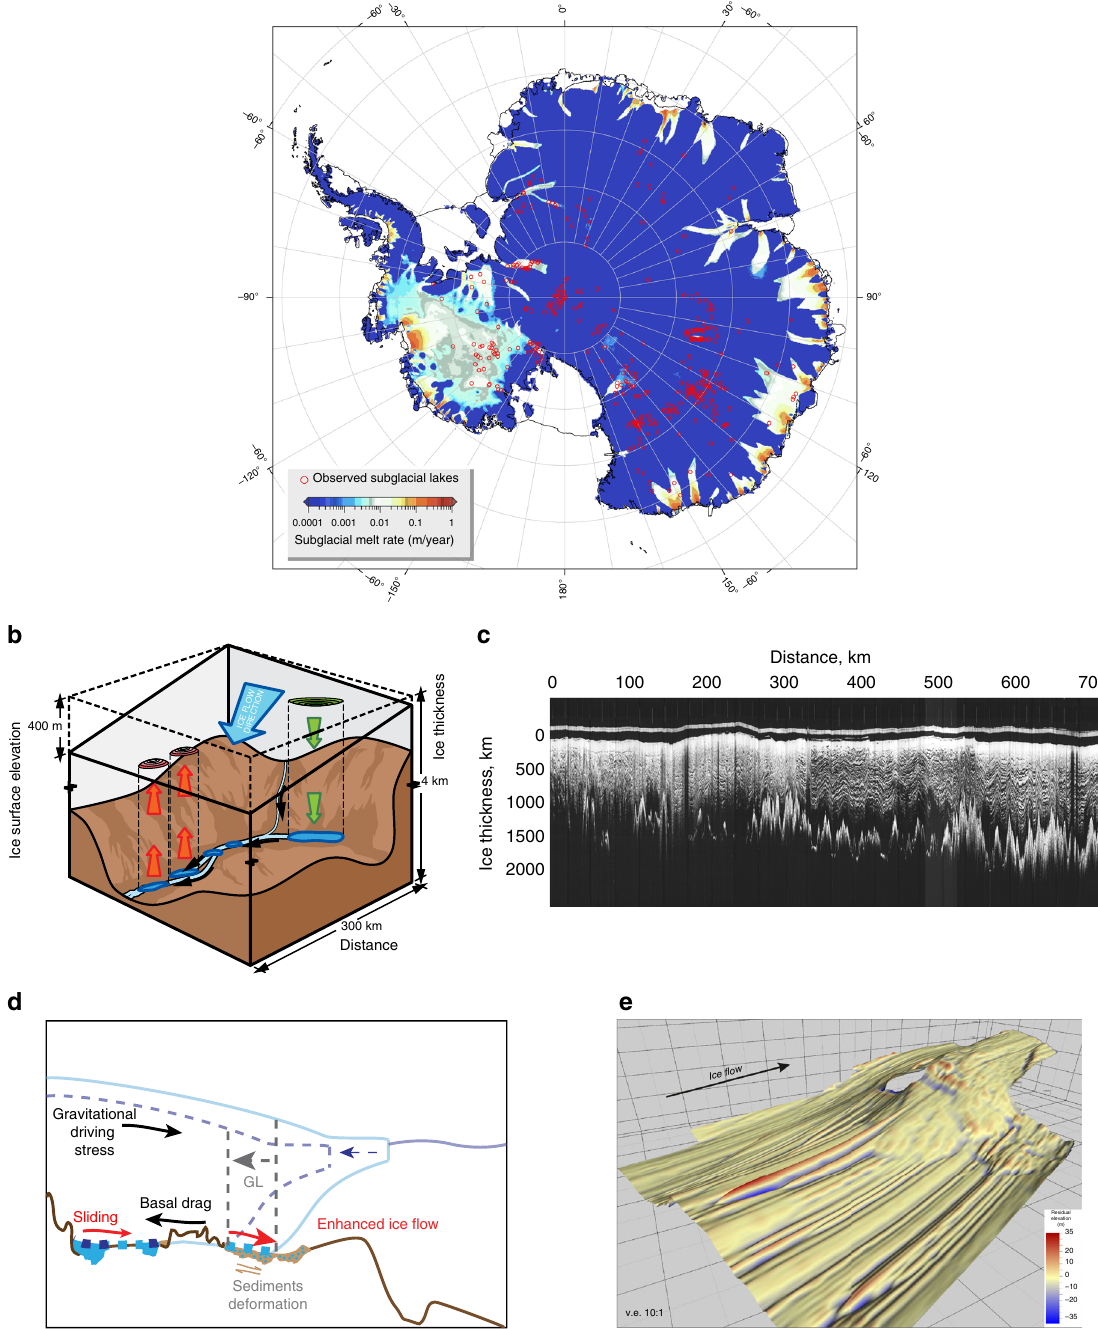
Fig. 2 Key elements of suglacial hydrology. a Current subglacial lakes locations 115 (red circles) superimposed on the rate of present-day basal meltwater production (ma − 1 ) simulated with the Parallel Ice Sheet Model at 5 km resolution (standard run, unpublished). b An illustration of rapid drainage and hydraulic connection of Antarctic subglacial lakes, inferred from satellite altimetric measurements of the ice-sheet surface over the Adventure Subglacial Trench, East Antarctica, between 1996 and 2003 27 . c Airborne radio-echo sounding transect across the Gamburtsev Subglacial Mountains in central East Antarctica. The transect was acquired by the Scott Polar Research Institute as part of a collaboration between the UK, USA, and Denmark in the late 1970s. The transect itself reveals mountains over 1 km in relief buried beneath the thick ice of the polar plateau. d Relationship between ice-sheet driving stresses, basal drag, basal sliding, and subglacial hydrology. Sliding induces a reduction in basal drag and accelerates ice fl ow. e Sedimentary landforms indicative of fast- fl owing grounded ice beneath the Rutford Ice Stream, as imaged from ice-penetrating radar 43 . Vertical exaggeration is 10 × . Sedimentary bodies such as these signi fi cantly in fl uence the dynamics of the Antarctic ice sheet by changing the topography of the bed and/or by enhancing sliding at the ice bed interface. Figure 2b has been adapted with permission from Springer Nature; Nature volume 440, pages 1033 – 1036, Duncan J. Wingham, Martin J.